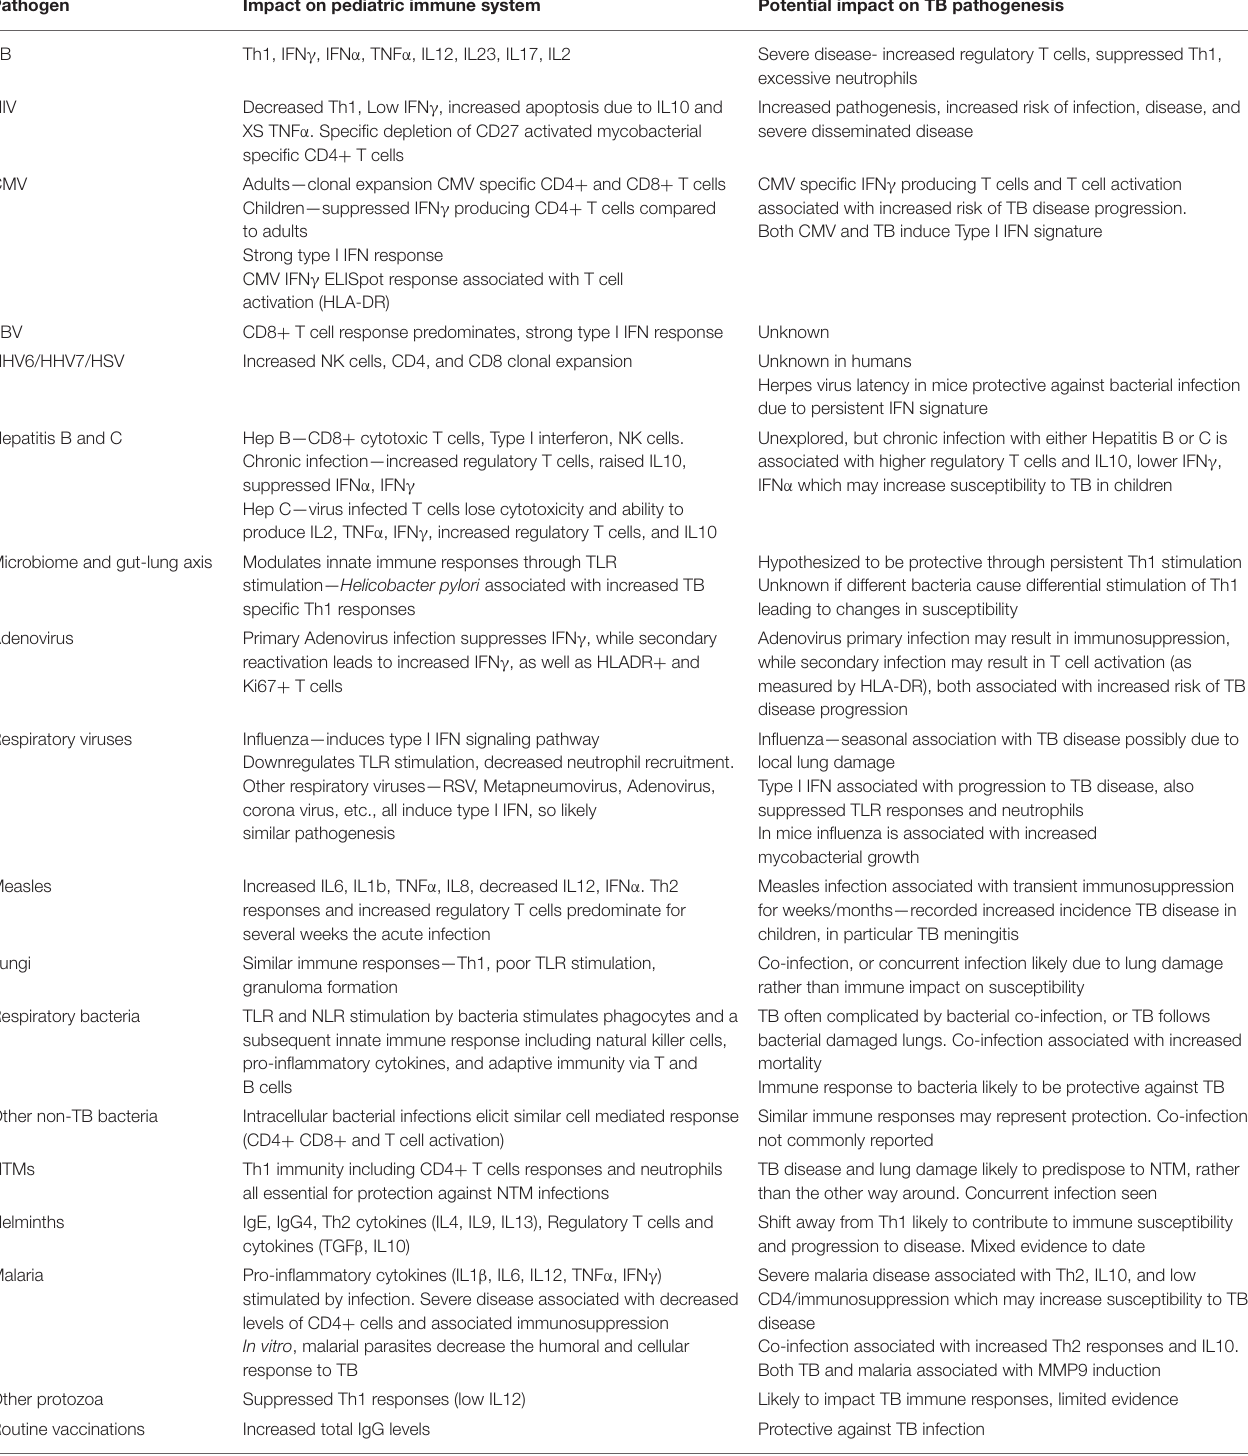
TABLE 1 | A summary of (1) the predominant immune response associated with a variety of pathogens in children and (2) the known impact of that pathogen on tuberculosis pathogenesis.